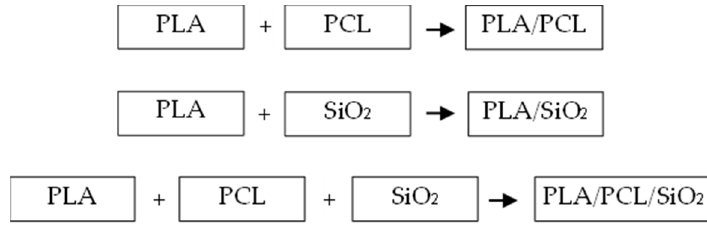
Figure 1. Schematic flow diagram of blending PLA with PCL and SiO 2 .